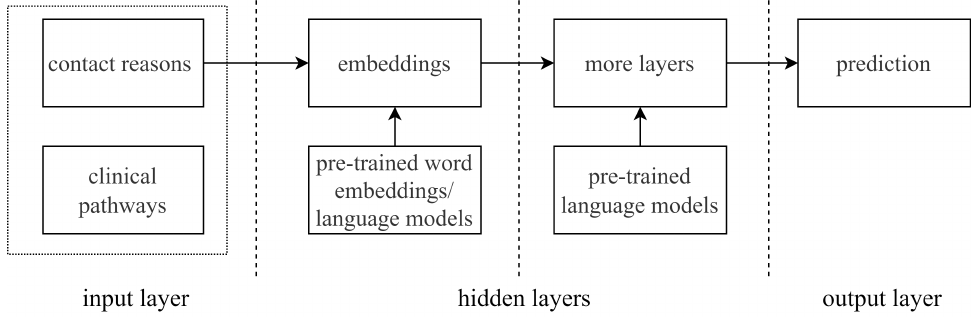
Figure 2. Using neural network architectures to build prediction models for the SNS24 clinical trial classification task. The input layer, hidden layers, and output layer are designed for each of the three neural network architectures accordingly. In the input layer, the “contact reason” and “clinical pathway” are fed to the neural network. In the hidden layers, the pre-trained word embeddings or language models are selected for each architecture accordingly. The output layer is designed to do the